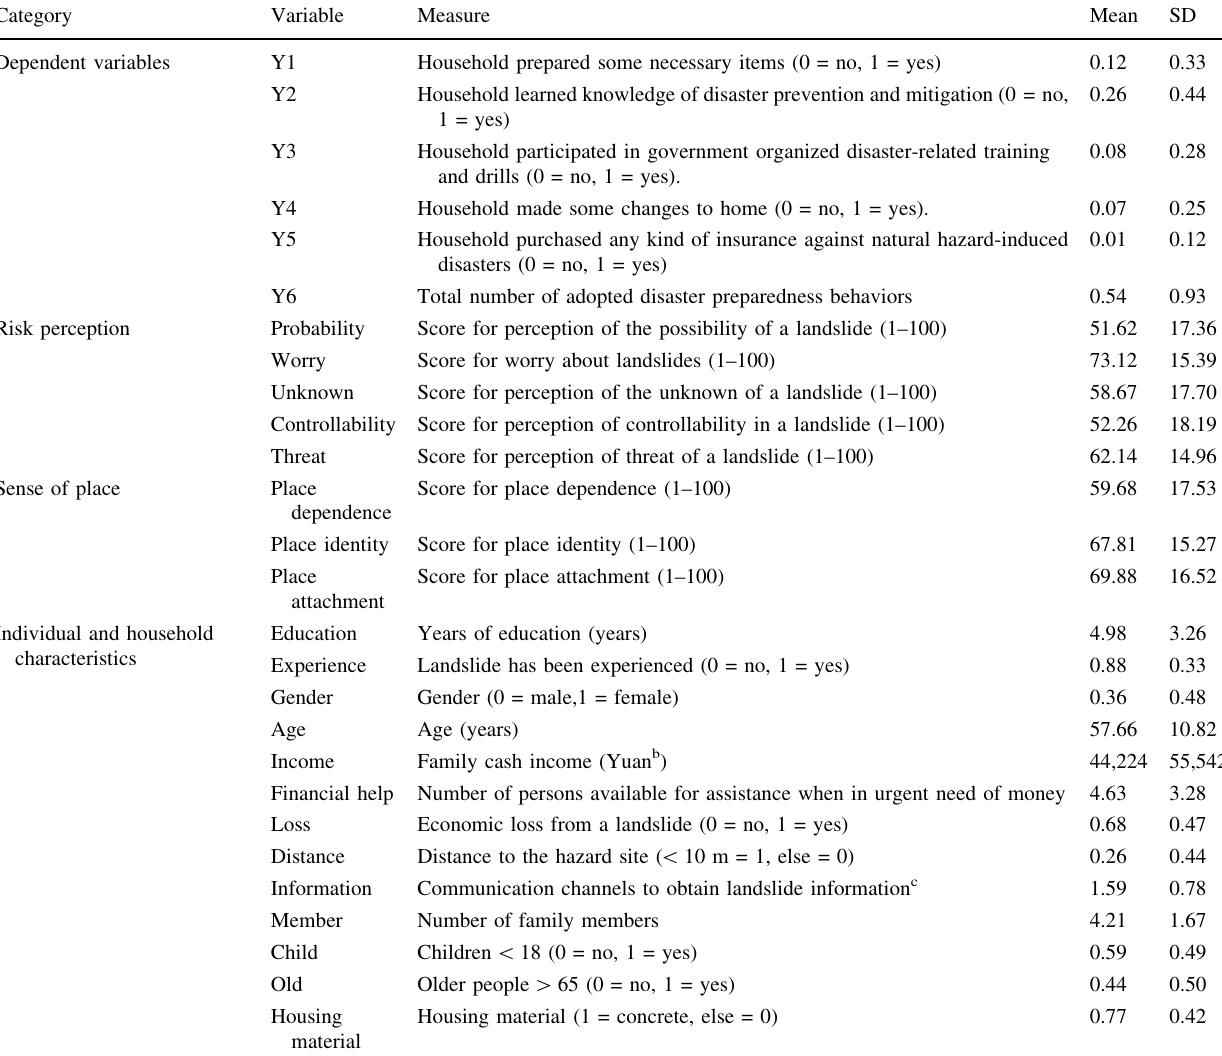
Table 5 Definition and descriptive statistics of the variables in the models used in the Three Gorges Reservoir area study a